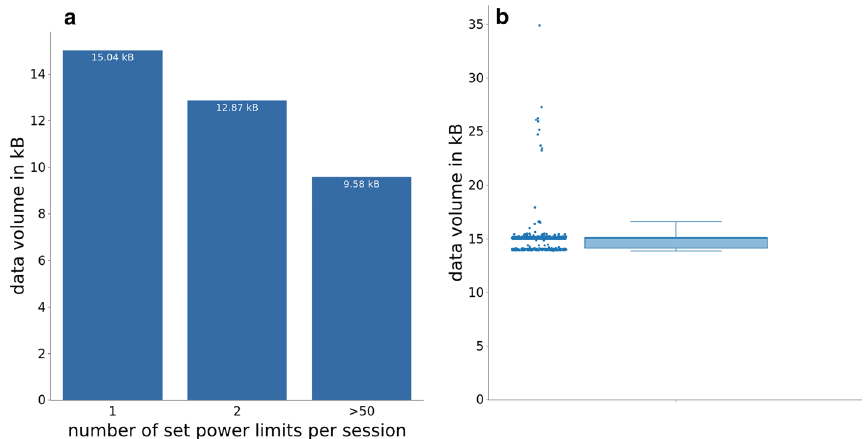
Fig. 5 Characteristical data volume for the transmission of a power